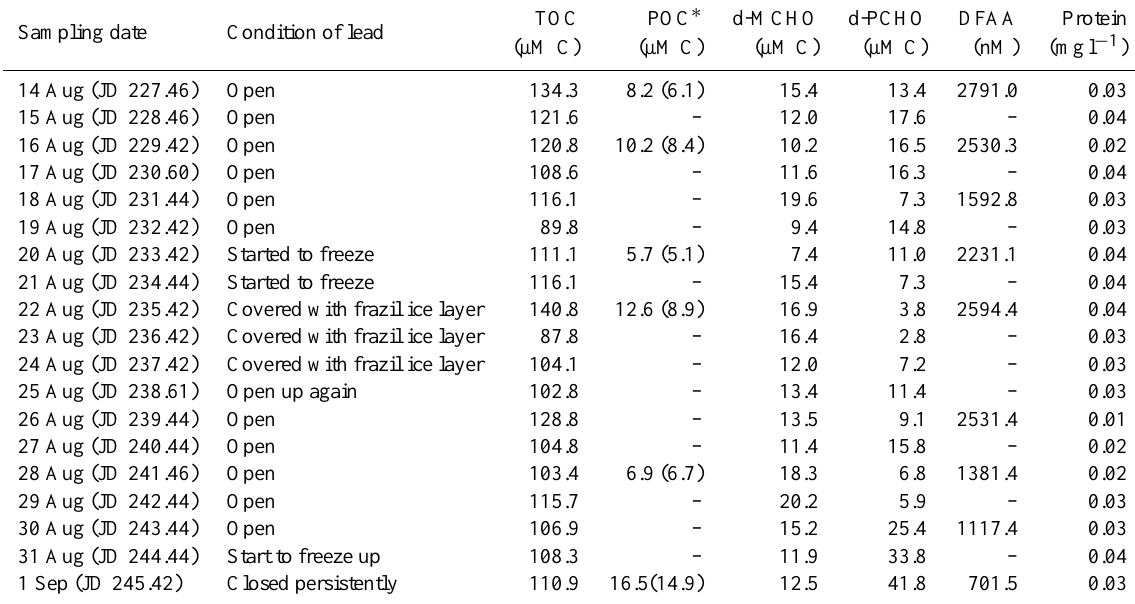
Table 2. Concentrations of particulate organic carbon (POC), total organic carbon (TOC), dissolved bulk free and combined carbohydrate (d-MCHO, d-PCHO), dissolved free amino acid (DFAA) and particulate protein in subsurface seawater of the open lead. The conditions observed at the lead site during each sampling day are